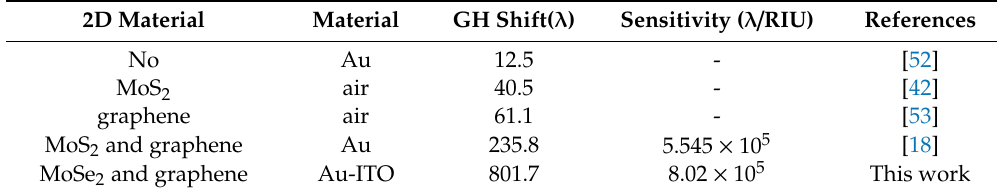
Table 3. Comparison with the formerly reported 2D-material-assisted SPR